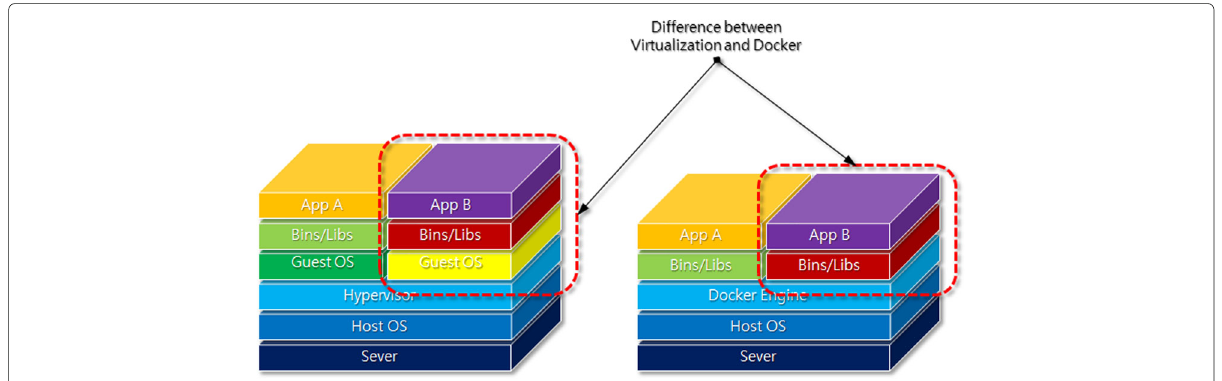
Fig. 2 Difference between virtualization (with hypervisor) and containerization (with